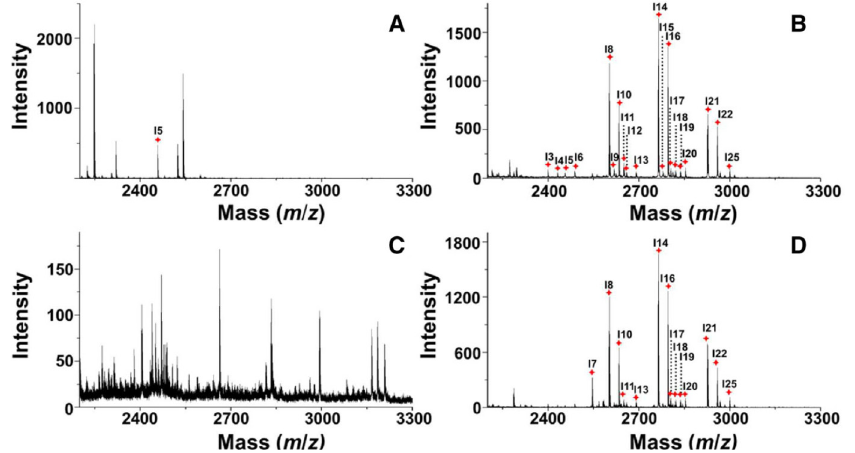
Figure 6. MALDI–TOF mass spectra of the mixture of BSA and IgG digests. ( A ) Direct analysis at a mass ratio of 10:1 ( B ) after enrichment by poly(GMAEDMA-CoPcTc) monolith at a mass ratio of 10:1, ( C ) direct analysis at amass ratio of 50:1, and ( D ) after enrichment by poly(GMA-EDMA-CoPcTc) monolith at a mass ratio of 50:1. Reprinted with permission from reference [96].